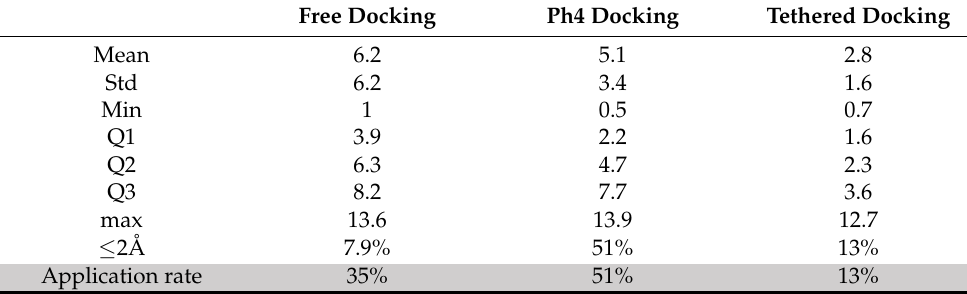
Table 3. RMSD values and percentage of cases for each docking protocol.